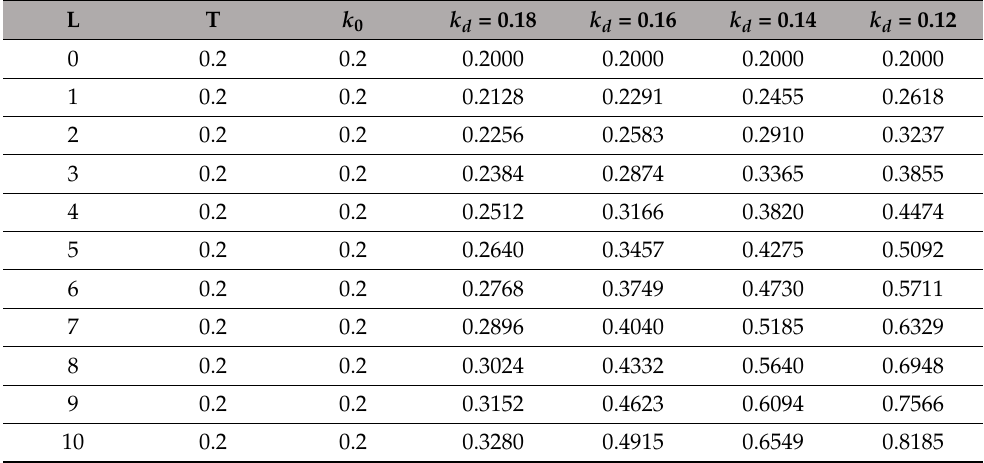
Table A12. Dependence of the equity cost, k e , on leverage level L at p = 12 and at different k d =